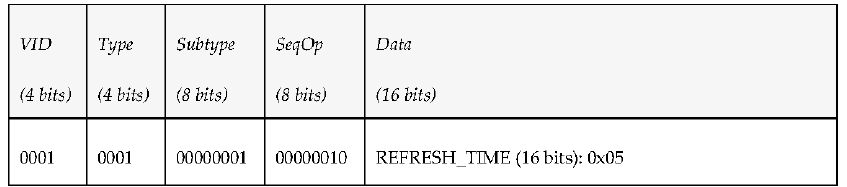
Figure 14. Appearance of the PDU used as a request for periodic mission status data.